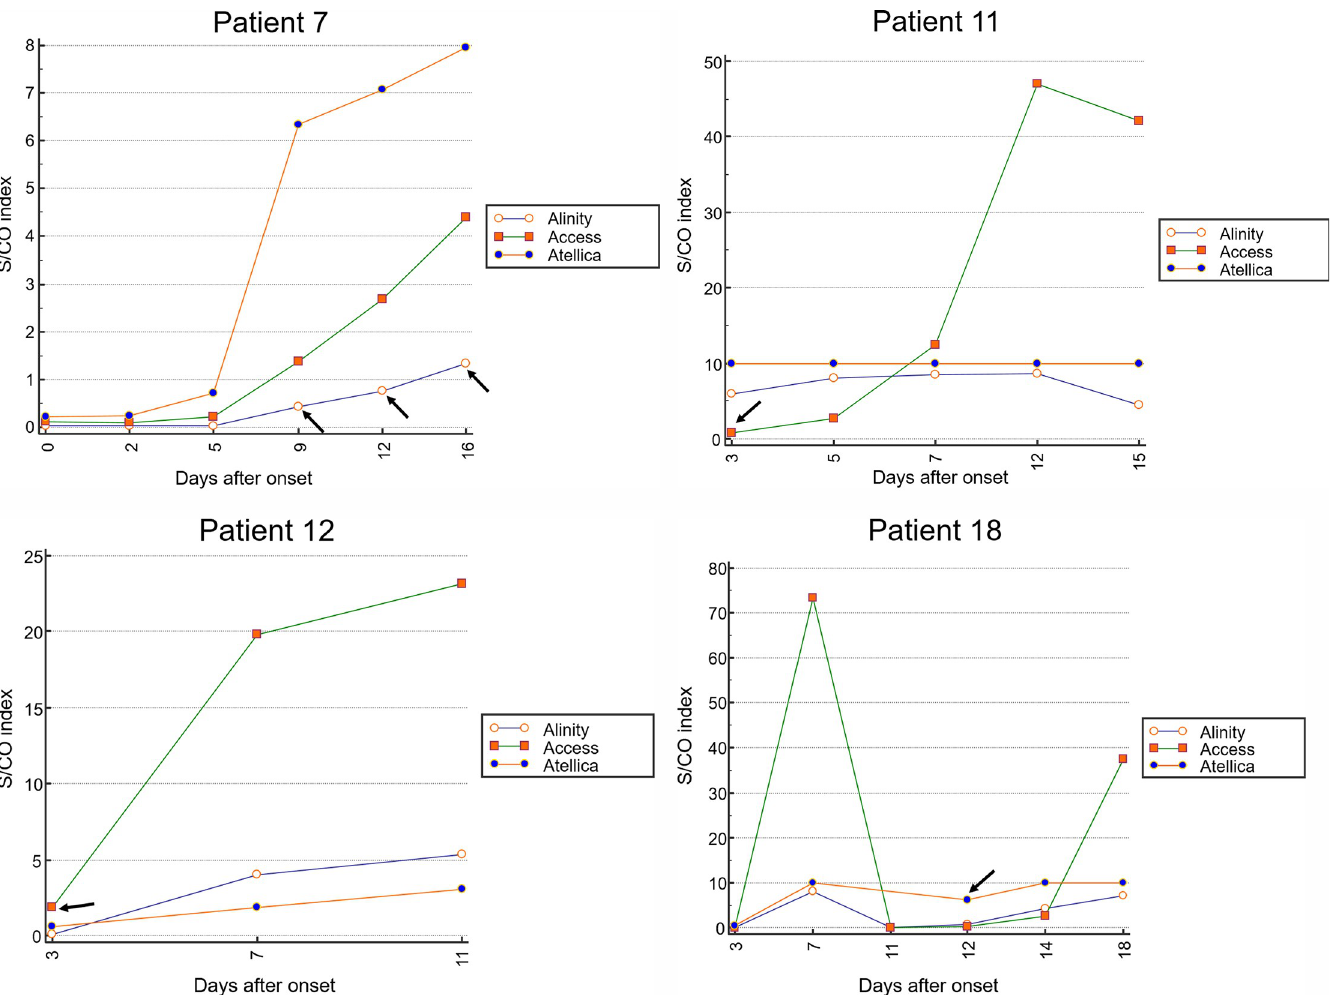
Fig 4. Dynamic profiling of serum SARS-CoV-2 antibody measured by three chemiluminescence immunoassays. The black arrow indicates the specimens showing inconsistency among the three equipment. (A) Alinity CoV-2 IgG on days 9, 12, and 16 was negative, and Access/Alinity showed positive on the same specimens. Only the specimens measured by Access on the 3 rd day after symptom onset was negative (B) and positive (C). (D) Atellica CoV-2 Total antibody was positive on the 12 th day, whereas the other two reagents were negative on the same specimen.